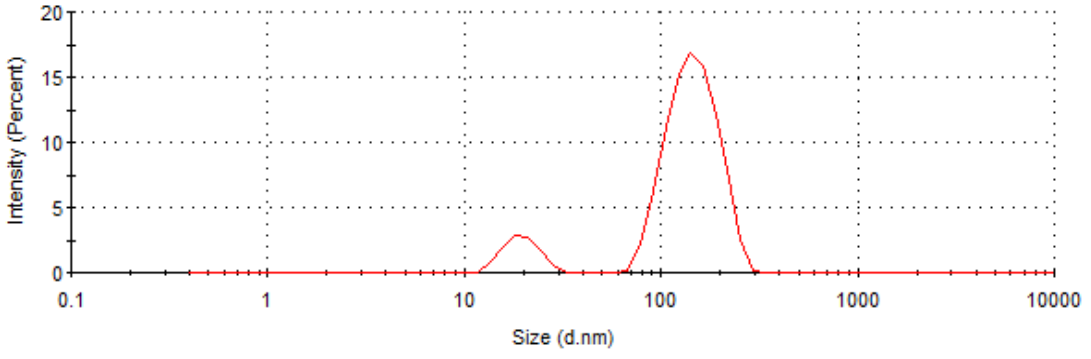
Figure 11. DLS size distribution histograms of poly-6-MOEG-9-T- BF3k -FE dispersions in ultrapure water.